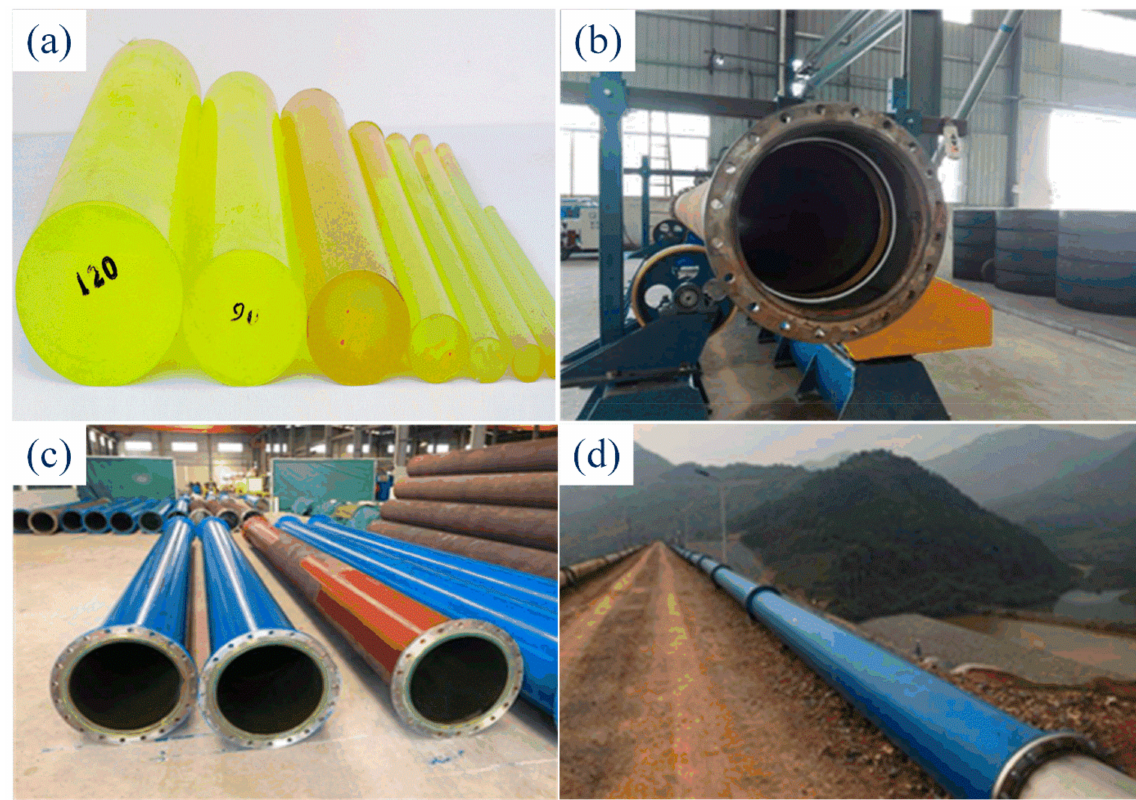
Figure 3. (Sourced from Changsha Green Mine Environmental Protection Technology Co. LTD). Ultra high molecular polyurethane composite wear resistant pipe: ( a ) polyurethane rod; ( b ) centrifugal casting process; ( c ) steel lined carbon nano polyurethane wear resistant pipe; ( d ) application of tailings conveying pipeline in the Dabaoshan Mining